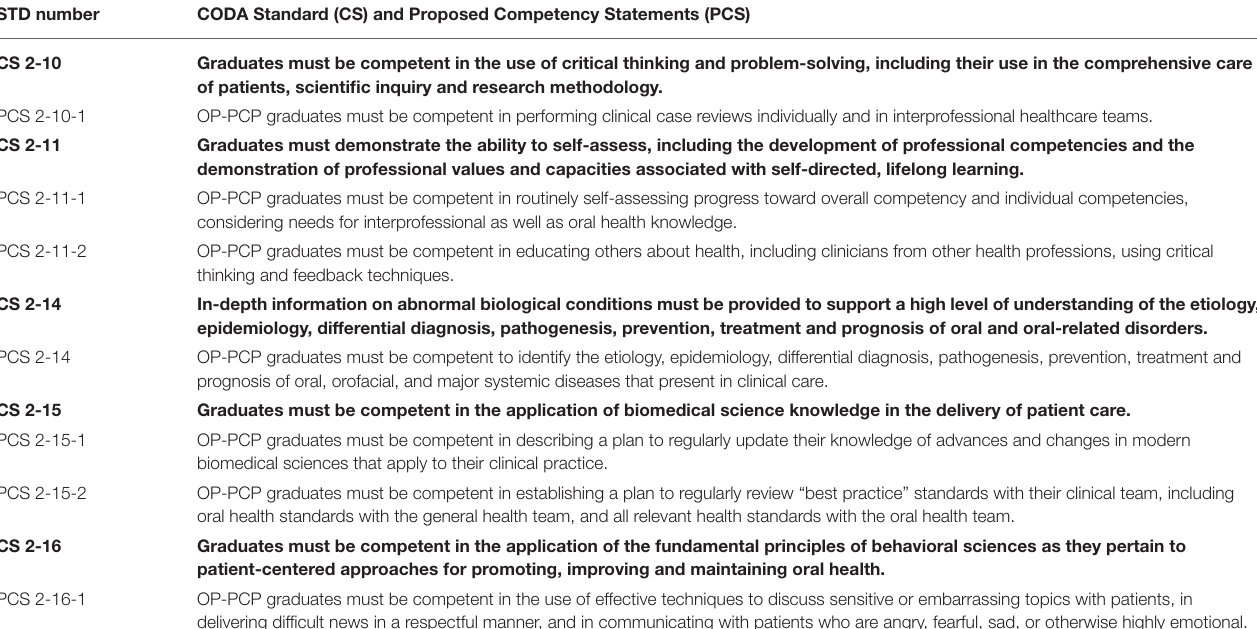
TABLE 1 | CODA Standards (CS) except CODA 2-24, and related Proposed Competency Statements (PCS) for Oral Physician - Oral Health Primary Care Provider (OP-PCP). STD